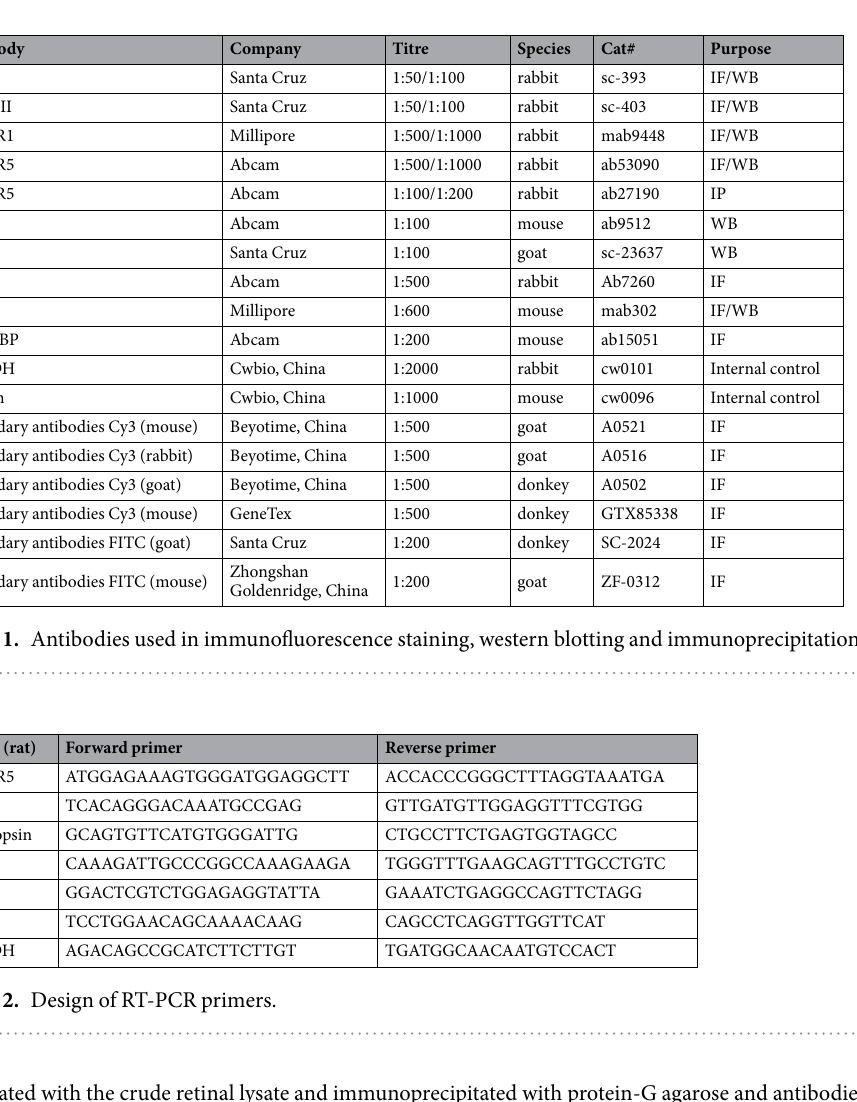
incubated with the crude retinal lysate and immunoprecipitated with protein-G agarose and antibodies, accord- ing to the manufacturer’s instructions (shown in Table 1). Sodium dodecyl sulfate polyacrylamide gel electropho-